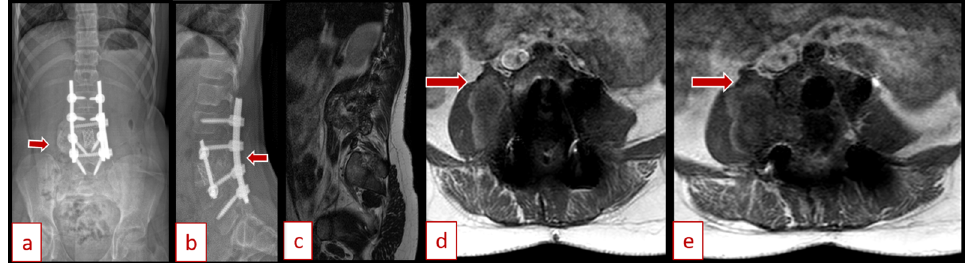
Figure 3. (a) EOS (Low dose radiation imaging device) spine PA view preoperative (February 2017). (b) Spine lateral view preoperative (February 2017). (c) Preoperative sagittal MRI demonstrating recurrent osteosarcoma (December 2016). (d, e) Preoperative axial MRI demonstrating recurrent osteosarcoma proximity to neurovascular structures (December 2016).